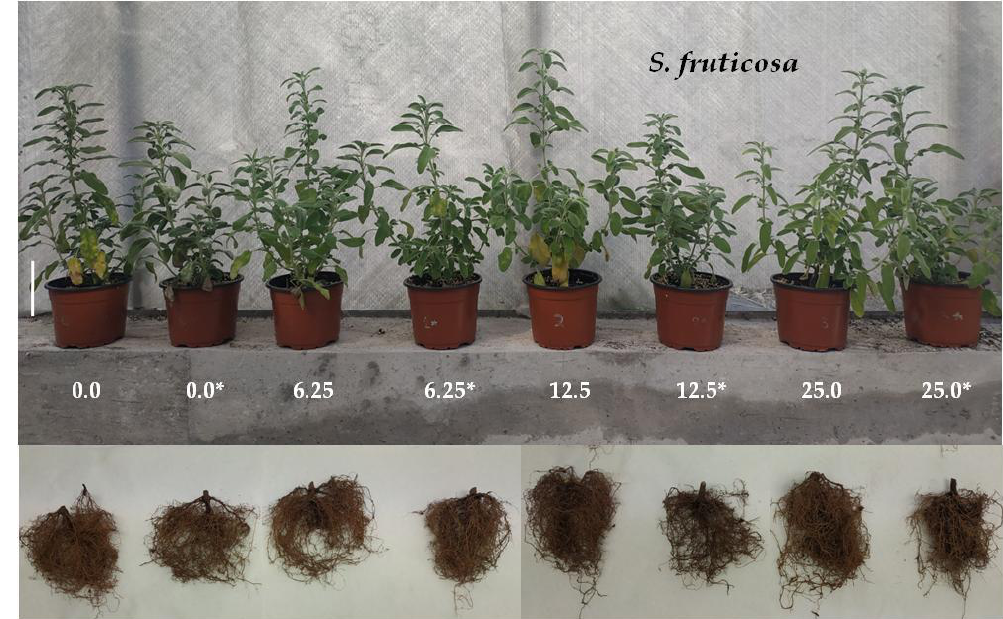
Figure 2. Typical canopy and roots of S. fruticosa , after having grown for three months in greenhouse conditions in a peat-perlite 2:1 ( v / v ) substrate containing marked concentrations (g/L) of attapulgite (* sparse irrigation). Size bars = 10.0 cm.